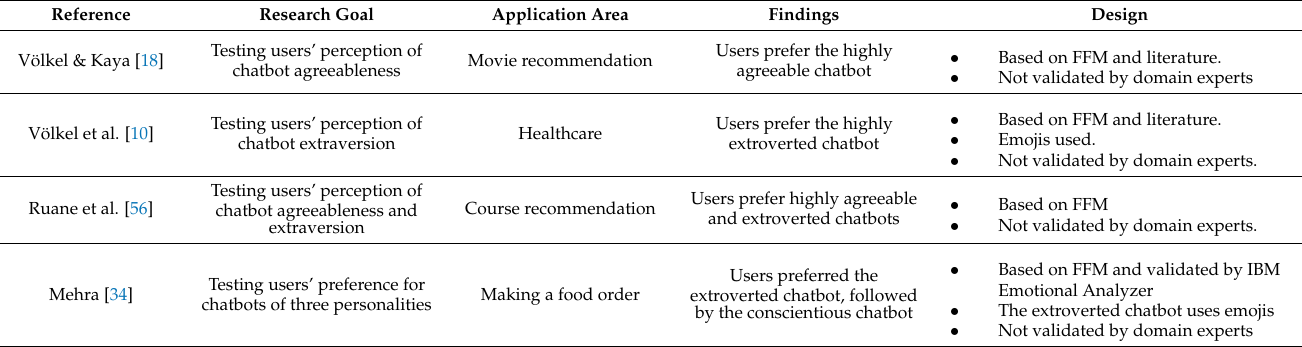
Table 1. An overview of text-based personality-imbued chatbots in the